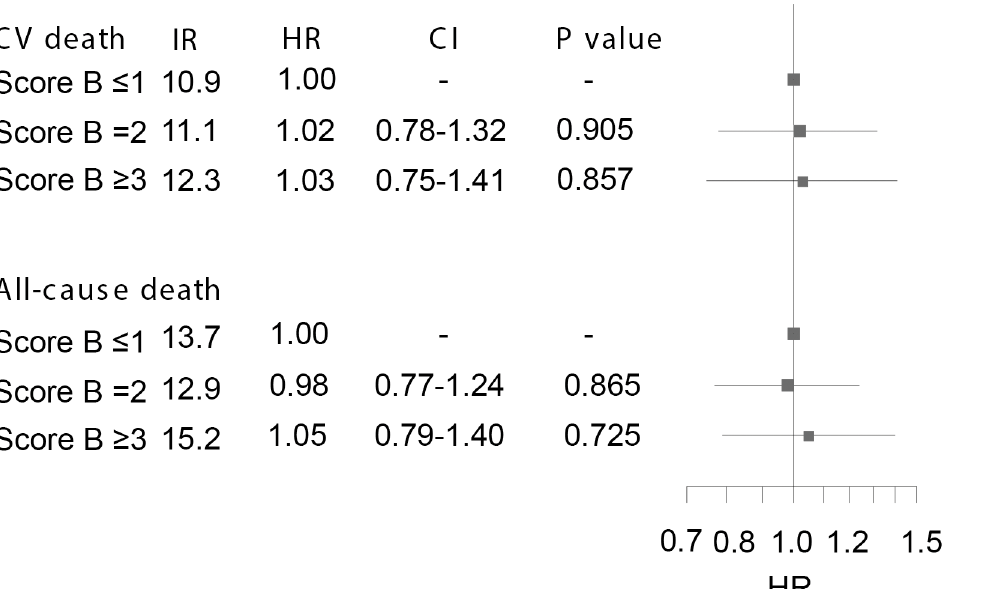
Fig 5. Risk of cardiovasclar (CV) death and all-cause death in angiotensin-converting enzyme inhibitor-treated patients with congestive heart failure stratified by genetic score B. Results from adjusted multivariate Cox proportional hazard analyses with score B (cid:1) 1 used as reference. IR: Incidence rate per 100 patient-years; HR: Hazard ratio. CI: confidence interval. Error bars illustrate 95%